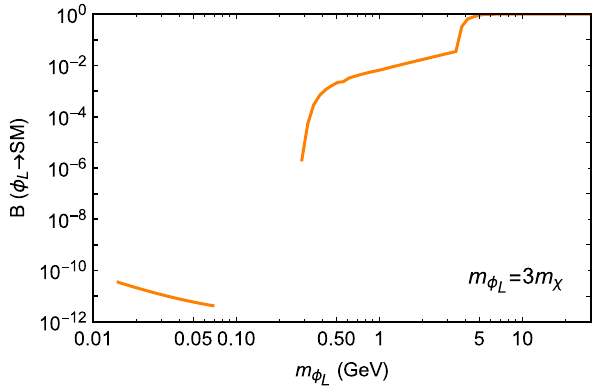
Fig. 2 The coupling parameter ξ as a function of m φ muon g − 2 anomaly (two bands), together with existing constraints (shaded regions) of NA64 [49] and revised BABAR limits [28], and projected search sensitivities. The projections of LDMX [50] and Belle II (revised results) [27] are shown by the dotted and the dot-dashed curves, respectively. Limits from ILC with 2 ab − 1 data at 250 GeV [29] are shown by the dashed curves, with the lower (upper) one correspond- ing to the exclusion (discovery) limit